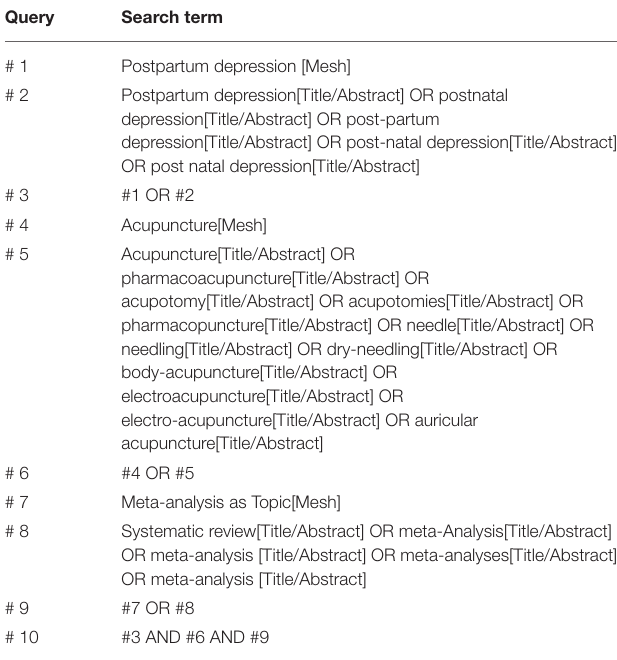
TABLE 1 | Search strategy for the PubMed